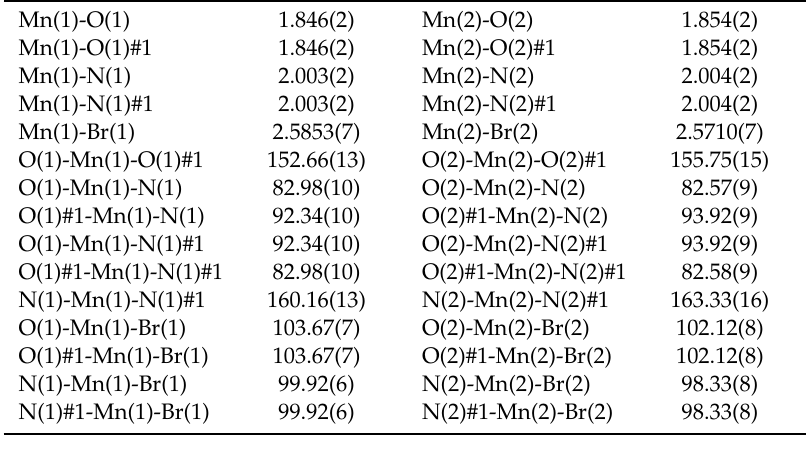
Table 2. Selected bond distances (Å) and angles (deg) of compound 1 .